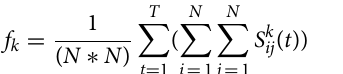
Frontiers in Neuroscience |